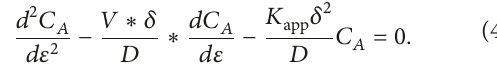
Figure 2: Scheme of one-dimensional mass transport across cat- alytic layer in flow-through membrane reactor (red particles are the catalysts, and 𝐶 𝐴0 and 𝐶 𝐴 are initial and final concentration of reactant 𝐴 ,